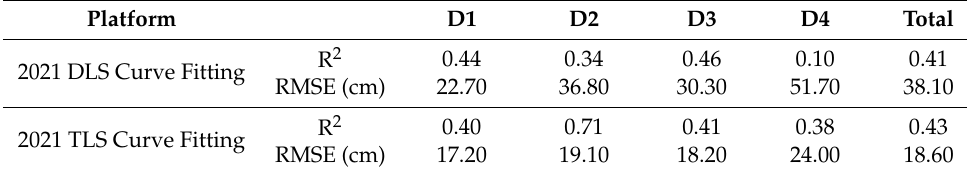
Table 11. R 2 and RMSE after curve fitting of data on different platforms in